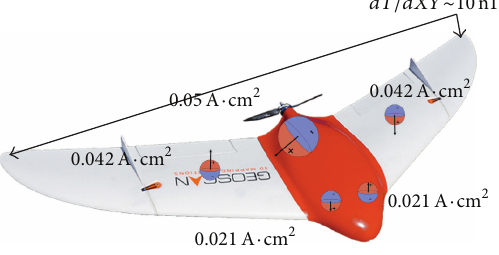
Figure 6: Location of UAV magnetic noise sources.